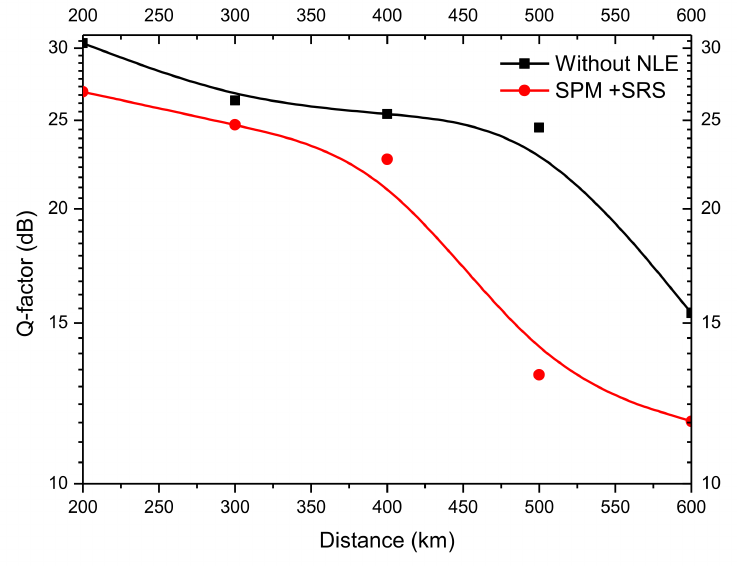
Figure 5. SAC-OCDMA system performance versus fiber